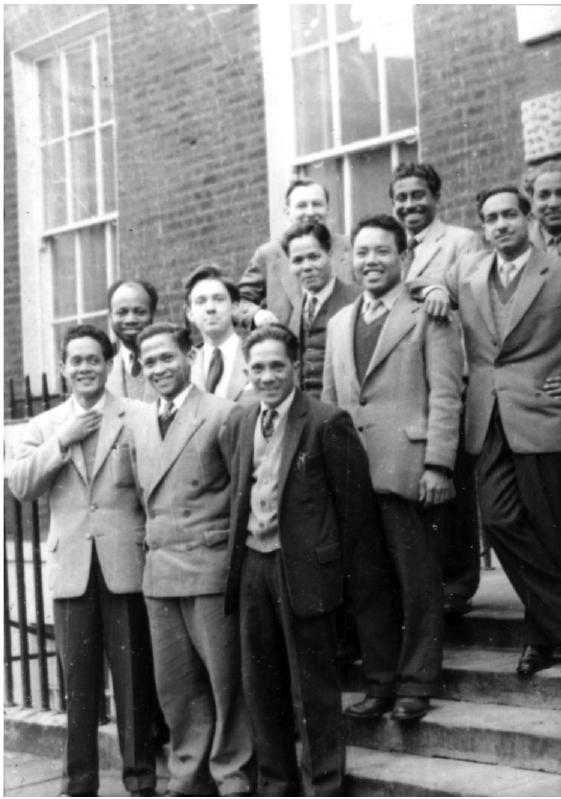
Figure 4. Photograph of a group of students from the fourth session of the tropical architecture course. Source: “A group of students from the fourth session of the trop‐